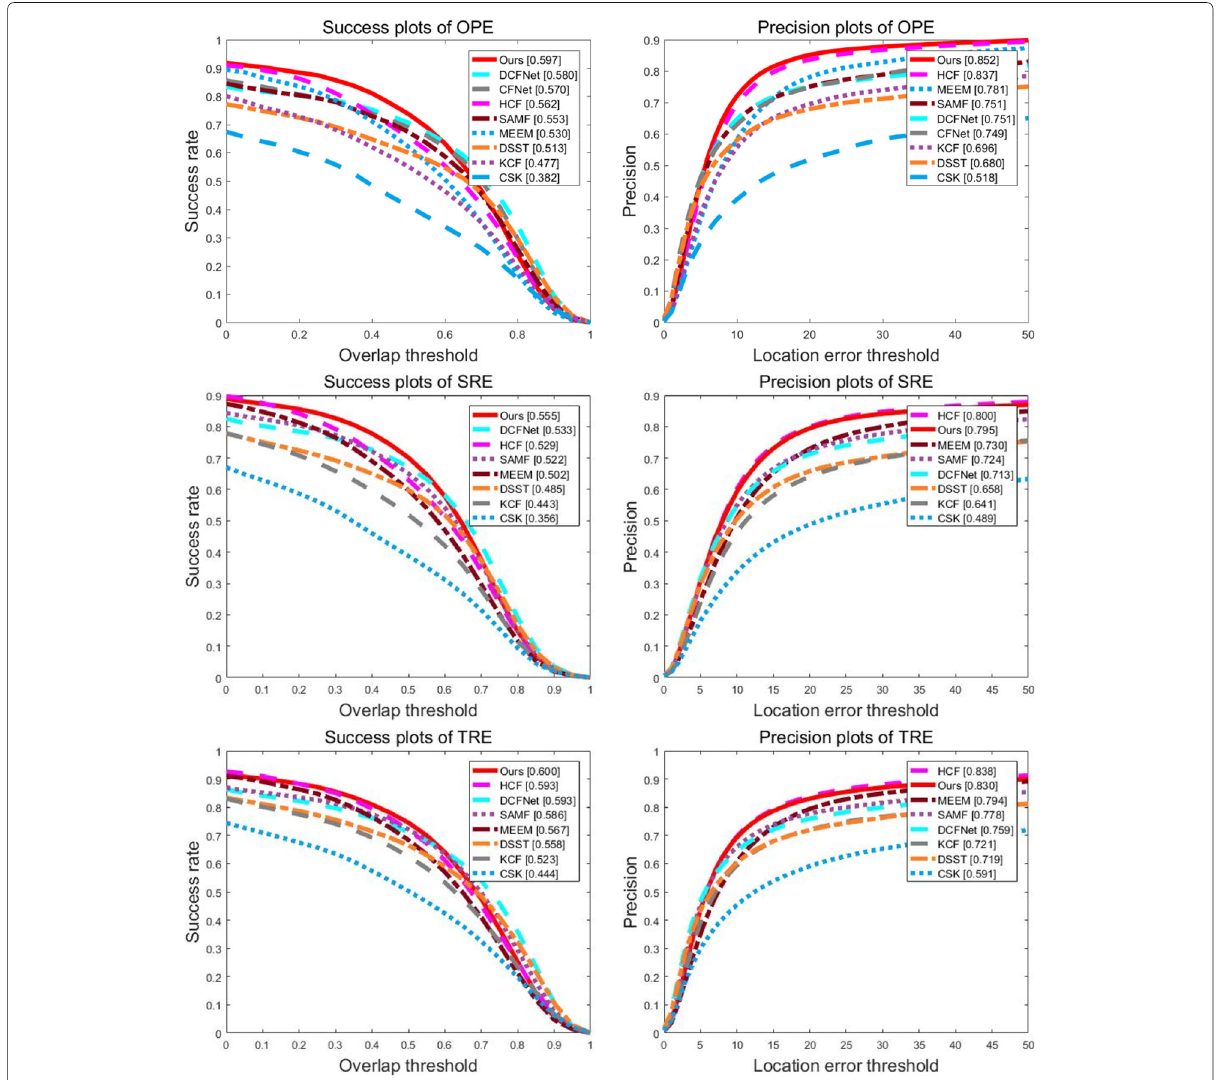
Fig. 5 Overlap success plots and Distance precision plots over 100 benchmark sequences in OPE, SRE,